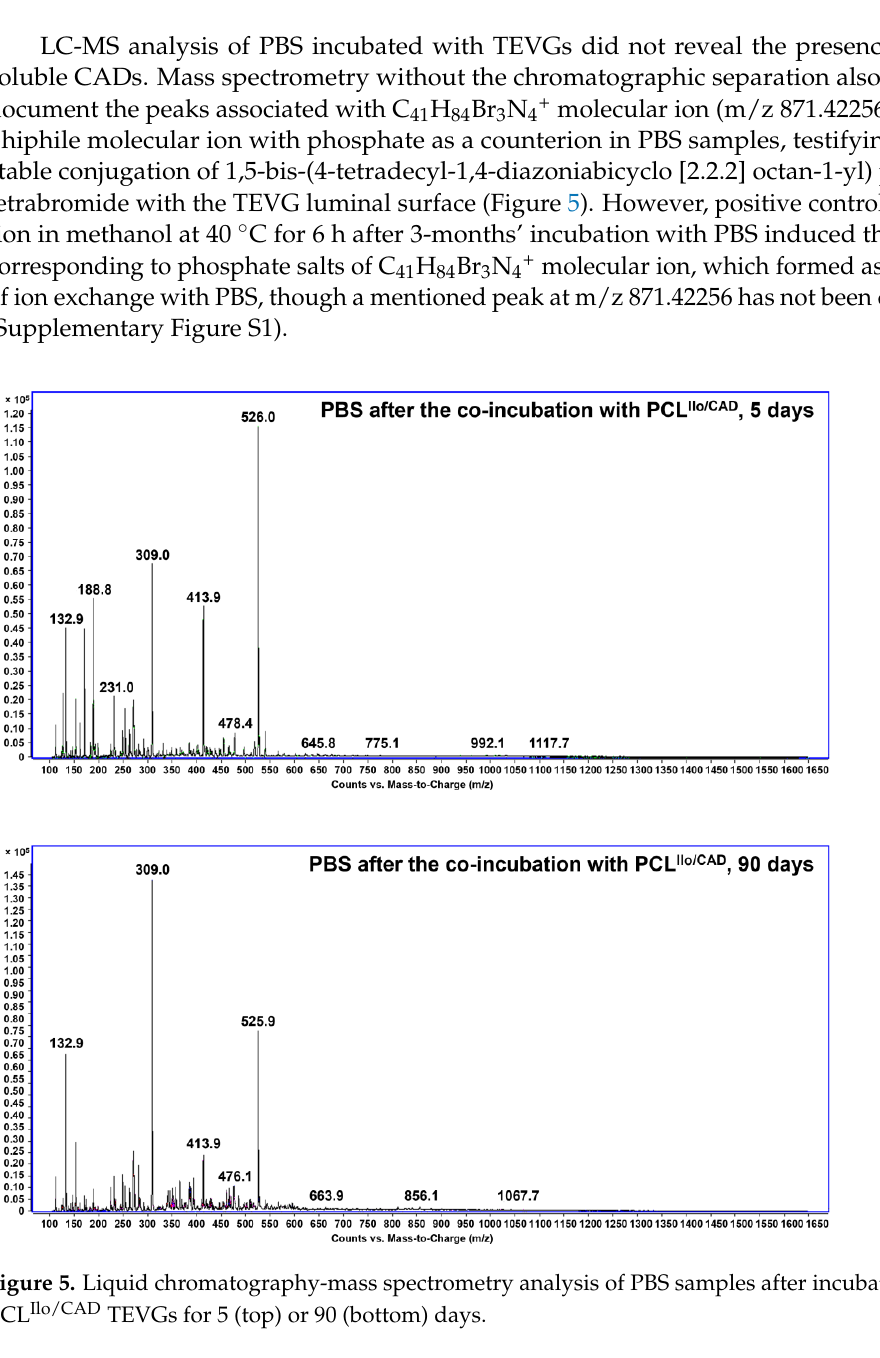
Figure 4. Chemical characterisation of the cationic amphiphilic drug 1,5-bis-(4-tetradecyl-1,4-diazo- niabicyclo [2.2.2] octan-1-yl) pentane tetrabromide attached to the TEVG. ( a ) Scanning electron mi-